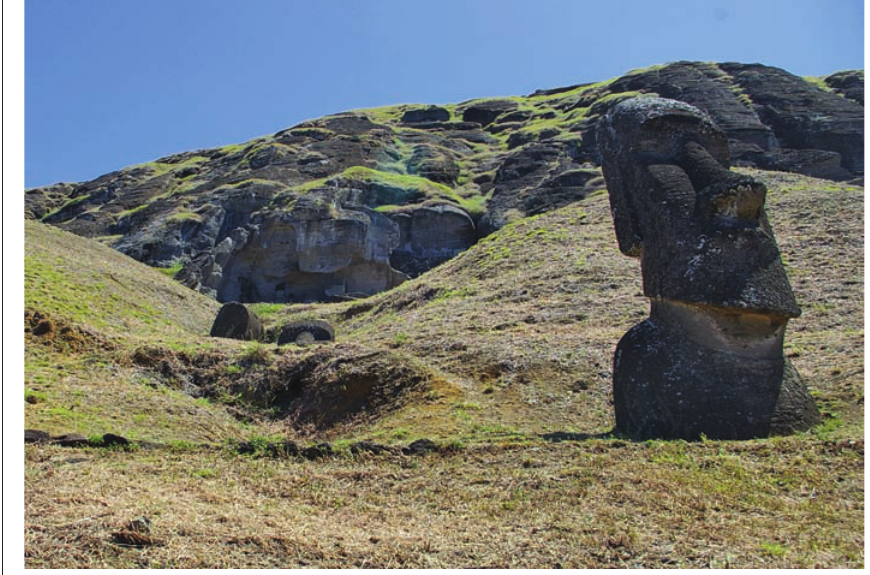
Figure 7 Rano Raraku quarry bay, spoil heaps and one of the set-up statues encircling the quarry and facing